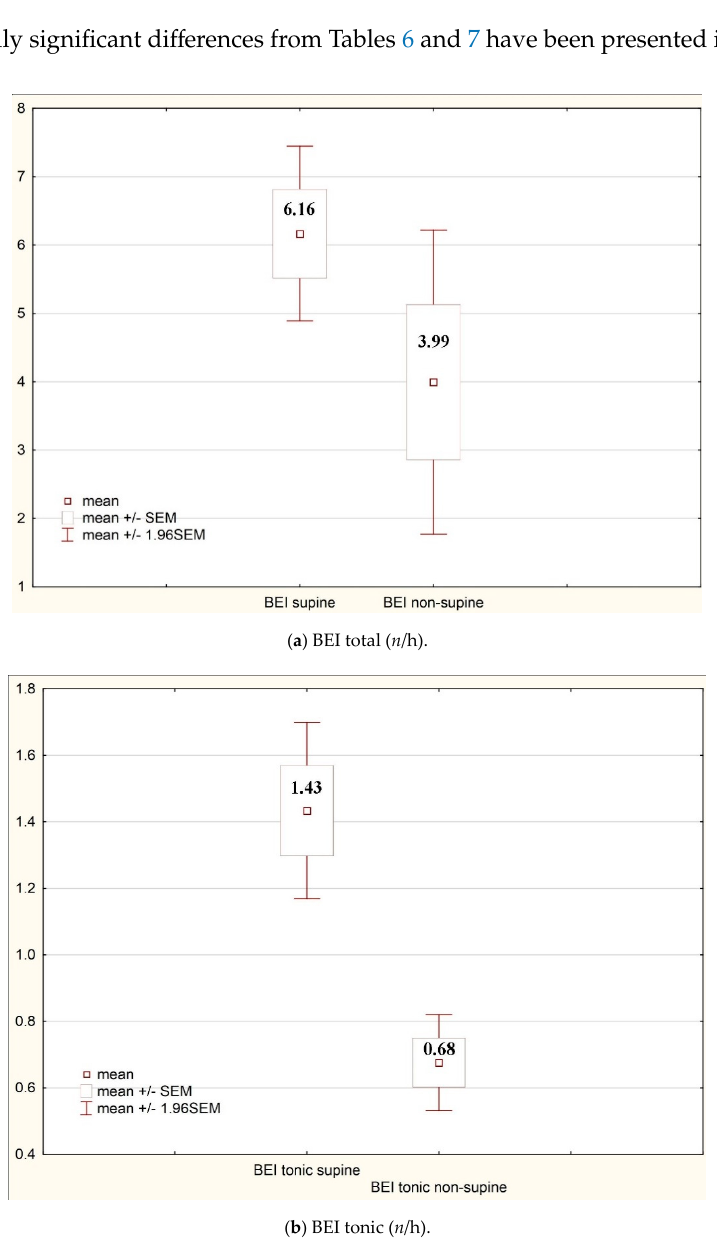
Figure 1. Impact of the body position on bruxism